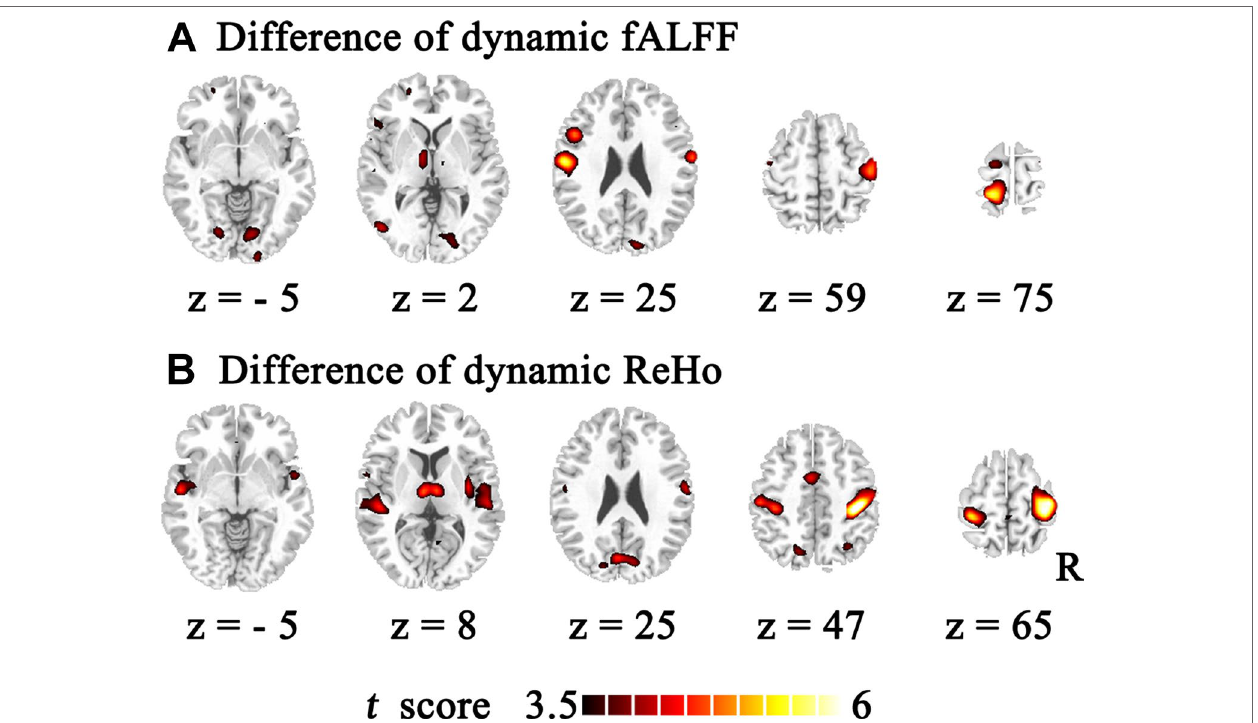
FIGURE 2 | Group difference of temporal variability of the dynamic fALFF and ReHo. Temporal variability of the dynamic fALFF and ReHo between schizophrenic and healthy subjects were identified using two-sample t tests. The significance level was set P FDR < 0.05. (A) The increased dynamic fALFF in schizophrenic subjects were compared with those of healthy controls. (B) The enhanced dynamic ReHo in patients with schizophrenia.